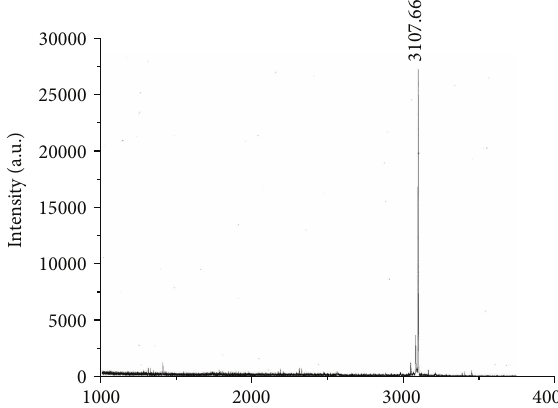
Figure 5: The Q-TOF profile of the recombinant N 𝛼 -acetylated T 𝛼 1.